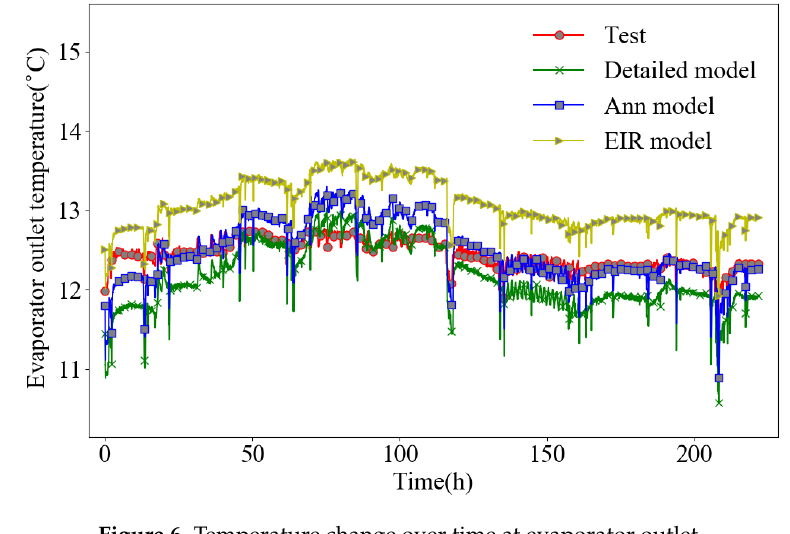
Figure 6. Temperature change over time at evaporator outlet.